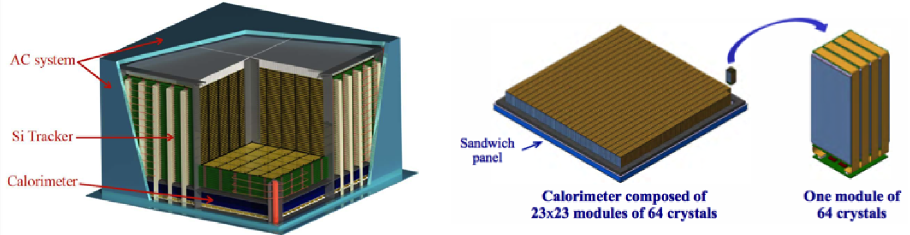
Figure 1: Overview of the e-ASTROGAM payload showing the silicon Tracker, the Calorimeter and the Anti-coincidence